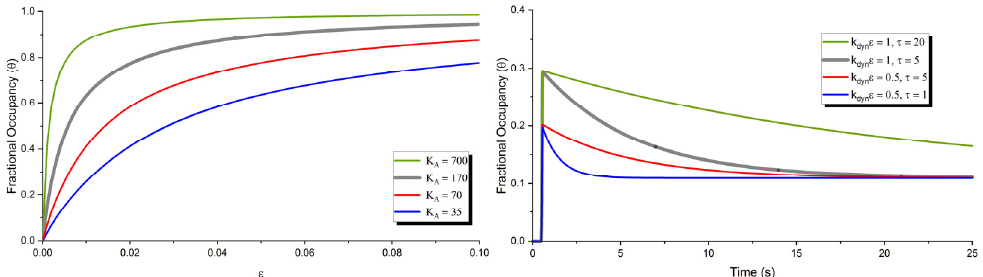
Figure 10. Variation of steady-state response parameter K A ( left ) in adsorption-based mathematical model and transient response parameters k dyn and τ ( right ) displaying effects on fractional occupancy of adsorption sites Θ .